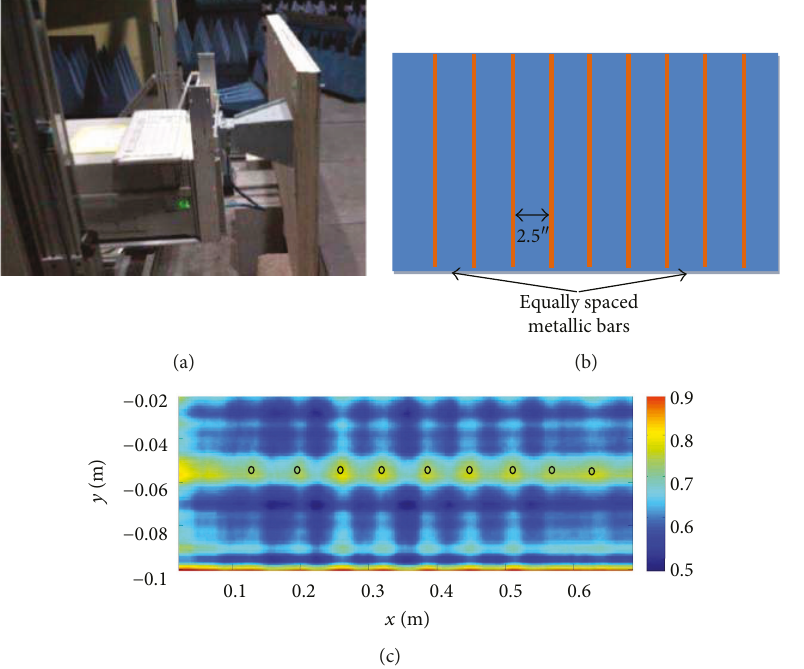
Figure 8: 1/3 scale cement board with metallic inclusions. (a) Measurement setup. (b) Layout of the wall interior. (c) Imaging result. The small circles indicate the true locations of the metallic bars.